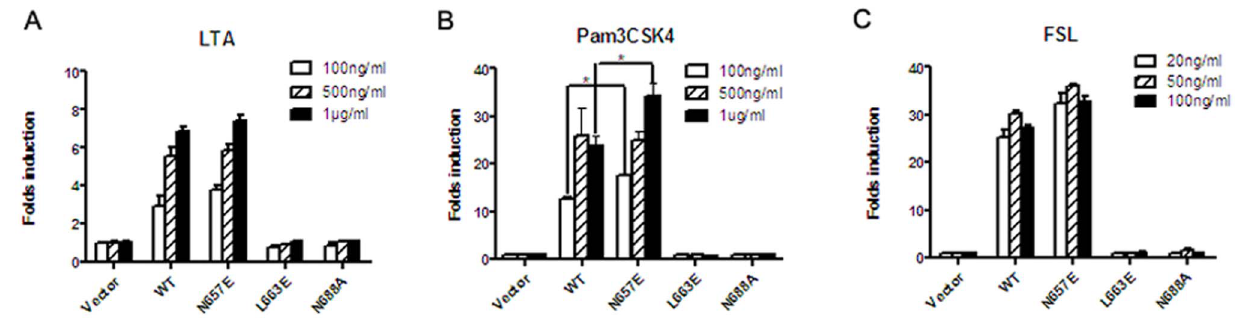
Figure 2. Responsiveness of human TLR2 (N657E), TLR2 (L663E) and TLR2 (N688A) to TLR2/2, TLR2/1 and TLR2/6 agonists. HEK293T cells in 24-well plates were transfected with human TLR2 (N657E), TLR2 (L663E) or TLR2 (N688A), and TK-RL and pBIIx-luc. At 24 h post-transfection, the cells were stimulated with the indicated concentrations of LTA (A), Pam3CSK4 (B) and FSL (C) for 6 h, respectively, and then both firefly and Renilla luciferase activities were determined using a dual-luciferase assay. The experiments were repeated for three times, and all of the data were expressed as the mean 6 SD. * indicated as p , 0.05.